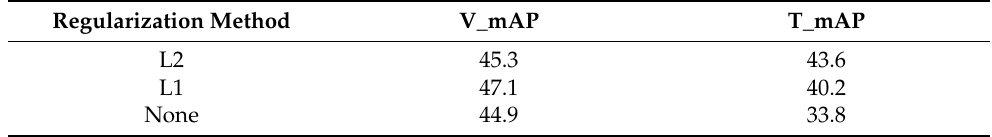
Table 6. Comparison of different regularization